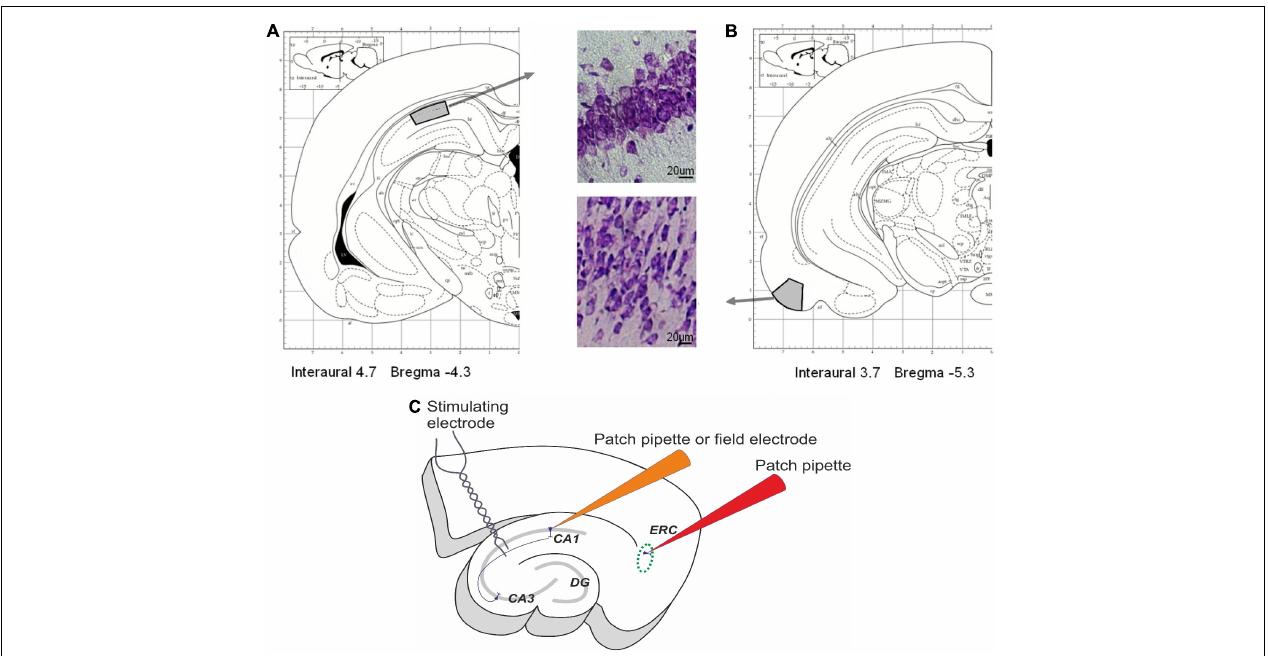
FIGURE 1 | Areas of interest in rat pup brains. (A , B) The areas of interest in the dorsal hippocampus (A) and entorhinal cortex (B) for histological investigations. Modified from Paxinos and Watson (2007). (C) The scheme of the field potential and whole-cell patch-clamp recordings. Field postsynaptic potentials (fPSPs) and population spikes (PSs) were recorded from CA1 stratum radiatum using glass microelectrodes. Afferent fibers were electrically stimulated by the bipolar electrodes placed in the Schaffer collaterals in the stratum radiatum at the CA1–CA2 border. The membrane properties of pyramidal cells in the deep layers of the medial entorhinal cortex and the CA1 area in the hippocampus were studied using the whole-cell patch-clamp